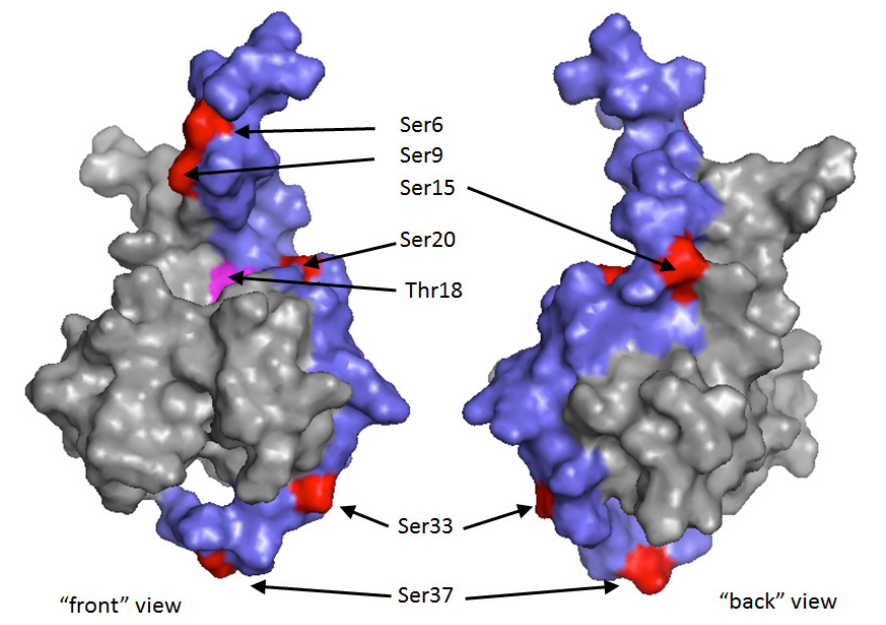
Figure 5. Location of key phosphorylation sites in the N-terminus of p53 within the context of p53/p300 association. The NMR-based structure of the N-terminus of human p53 (blue) in complex with the Taz2 domain of human p300 (grey) is shown (99). The figure depicts two views: termed "front" and, following rotation of approximately 180° around the vertical plane, "back". The positions of serine (red) and threonine (magenta) phosphorylation sites are shown. The data are taken from coordinates placed in the NCBI database (accession number: